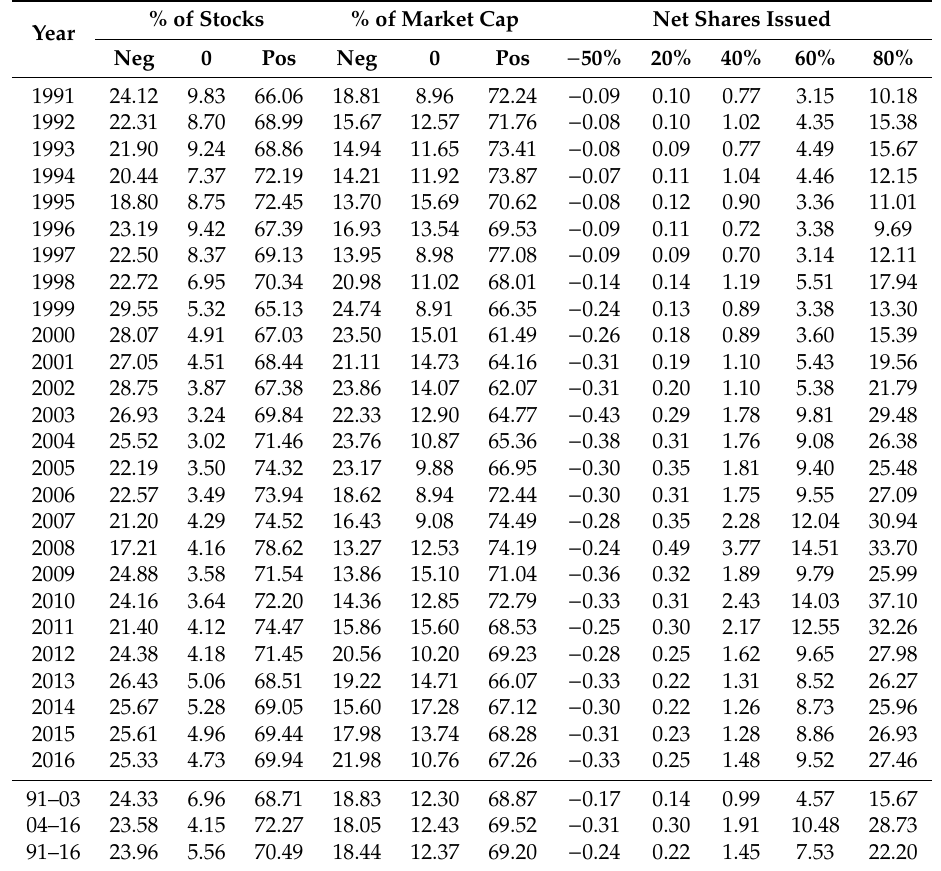
Table 12. Net Shares Issues—Asia 1991–2016. For Asia, net share issues (the number of shares issued minus repurchased) are computed for all stocks on an annual basis. Columns 2–4, % of Stocks, list the fraction of all stocks that are net repurchasers (Neg), net issuers (Pos) and that have zero net issues (0). Columns 5–7, % of Market Cap, list the percent of total market capitalization of net repurchasers, net issuers, and firms that do not repurchase or issue. The last five columns list the median percent share repurchase ( − 50%), as well as the quintile breakpoints for issues. The last three rows provide averages over the full sample, ‘91–16’, and over two subperiods, ‘91–03’ and